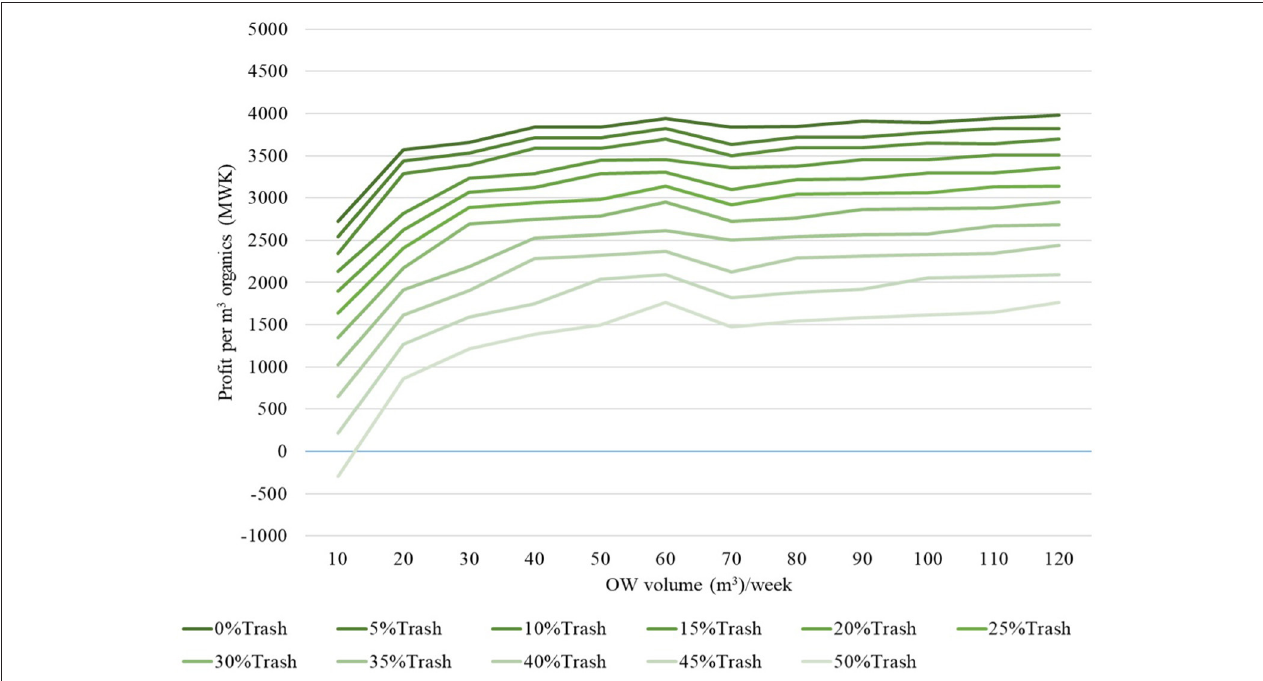
FIGURE 2 | Profitability as a function of plastic contamination at baseline model situation (capital expenditure